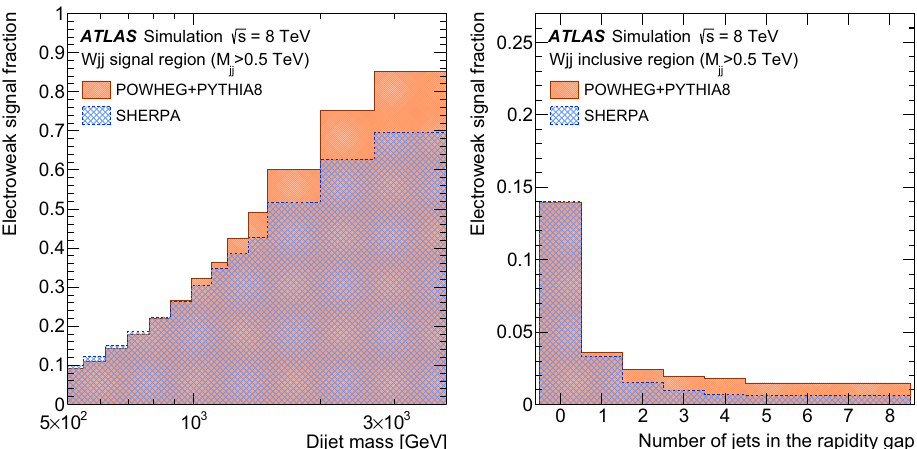
Fig. 15 FractionofEW W jj signalrelativetothe combinedQCD+EW W jj production, predictedby Powheg + Pythia8 and Sherpa simulations for observables in the signal ( left ) and inclusive ( right ) fiducial